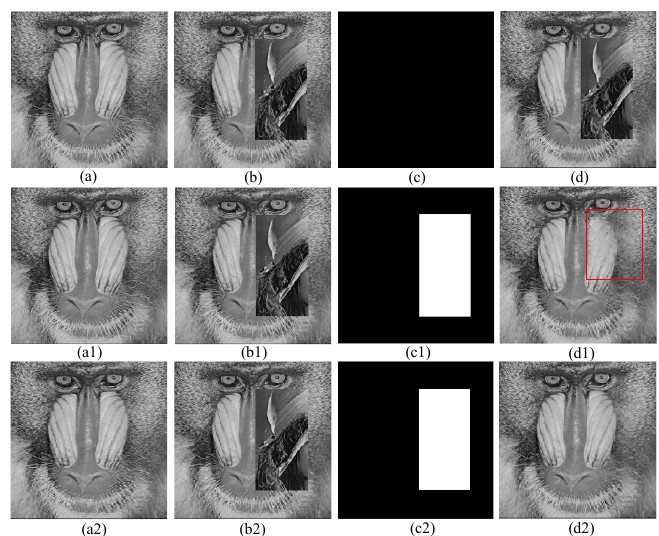
Figure 12. Collage attack simulation second kind: ( a ) Lee [1] watermarked image ( PSNR = 40.74 dB); ( b ) Lee tampered image; ( c ) Lee tamper detective image; ( d ) Lee recovered image ( PSNR = 16.55 dB); ( a1 ) Tai [5] watermarked image ( PSNR = 44.02 dB); ( b1 ) Tai tampered image; ( c1 ) Tai tamper detective image; ( d1 ) Tai recovered image ( PSNR = 31.57 dB); ( a2 ) proposed watermarked image ( PSNR = 40.71 dB); ( b2 ) proposed tampered image; ( c2 ) proposed tamper detective image; and ( d2 ) proposed recovered image ( PSNR = 32.35 dB).